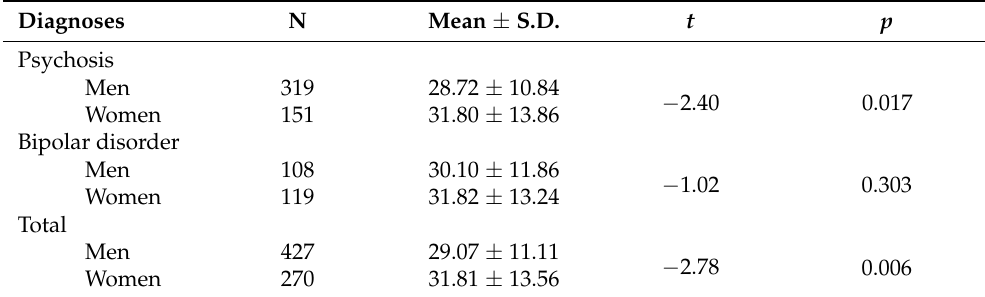
Table 7. Age of onset of symptoms of patients with severe psychiatric disorders ( n = 697). Diagnoses N Mean ± S.D. t p Psychosis Men 319 28.72 ± 10.84 Bipolar disorder